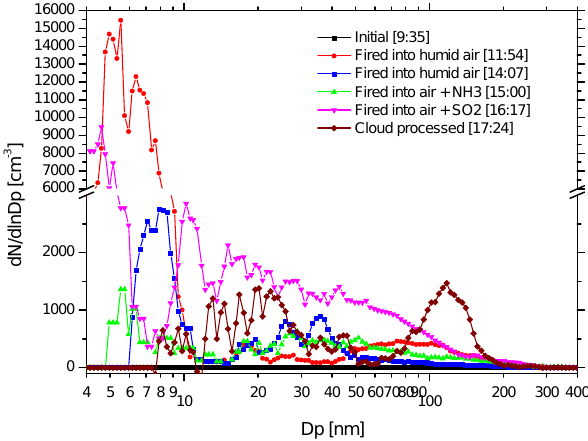
Fig. 7. Particle size distributions for selected times during exper- iments 5 and 8 in synthetic air at 283K and about 97% relative humidity. Times in the legend refer to Fig.